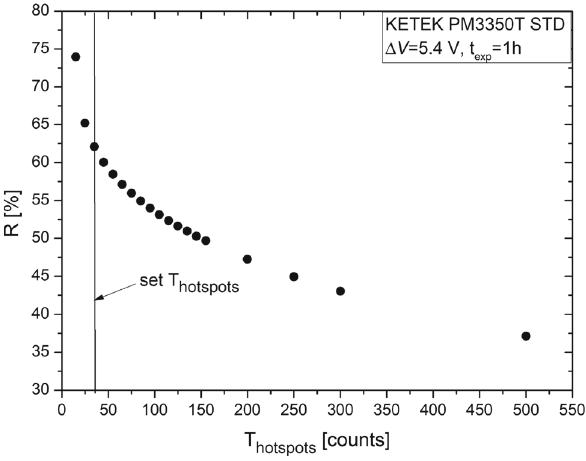
Fig. 12 Contribution R of the hotspots to the total DCR vs. T hotspots